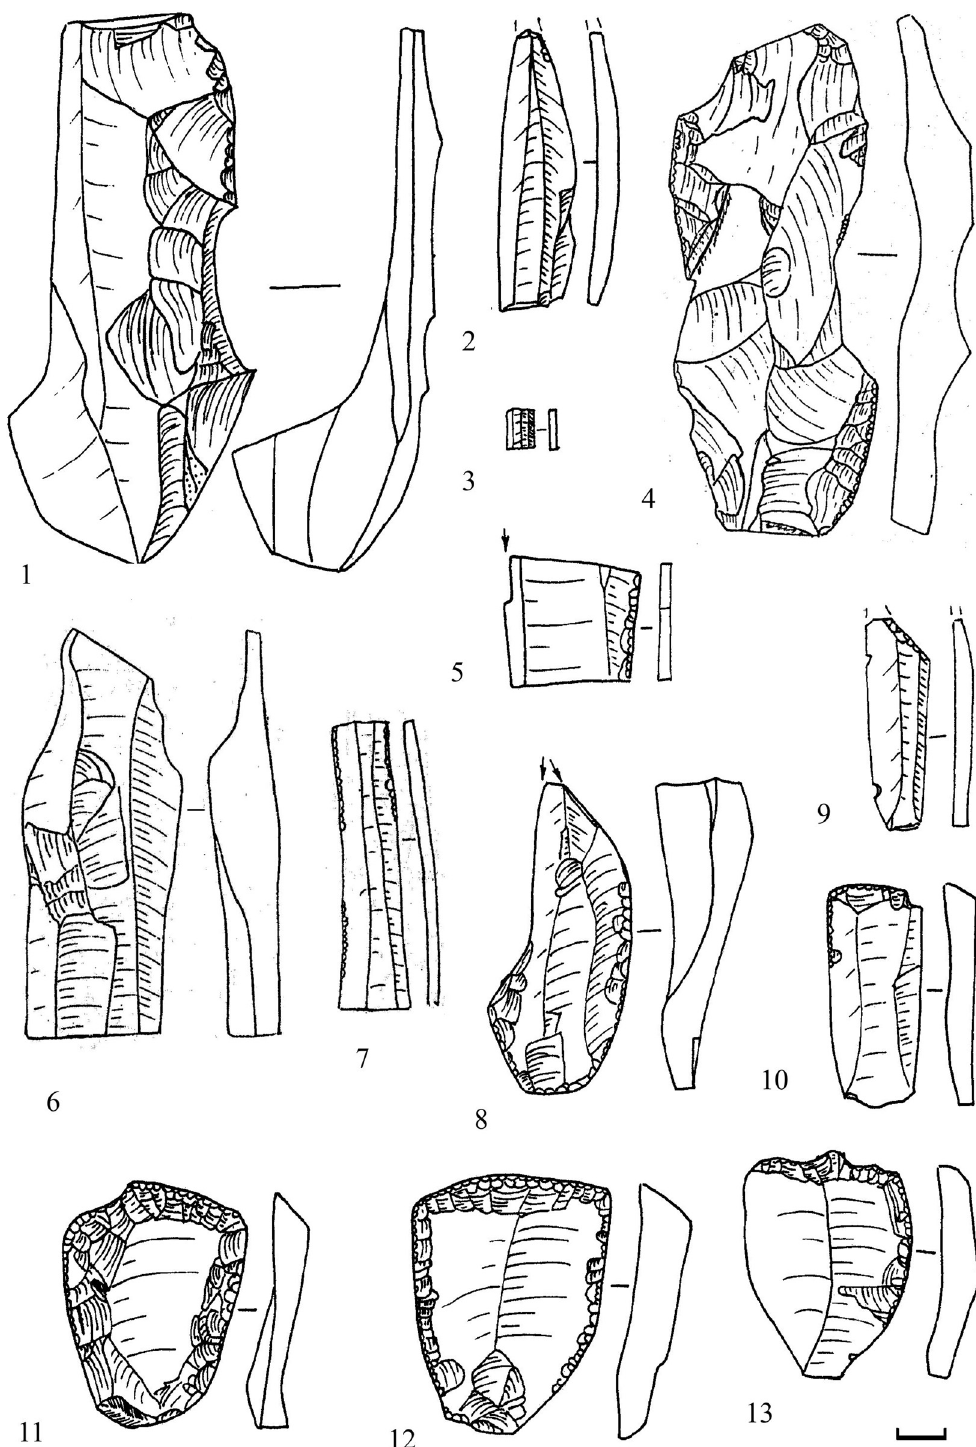
Figure 5: Flint complex from Chapaevka. 1 – distal part of overshot blade; 2, 6 – 7 – blades; 3 – bladelet; 4 – technical fl ake with retouch; 5 – simple burin; 8 – transversal burin; 9 – truncated blade; 10 – 13 – end -